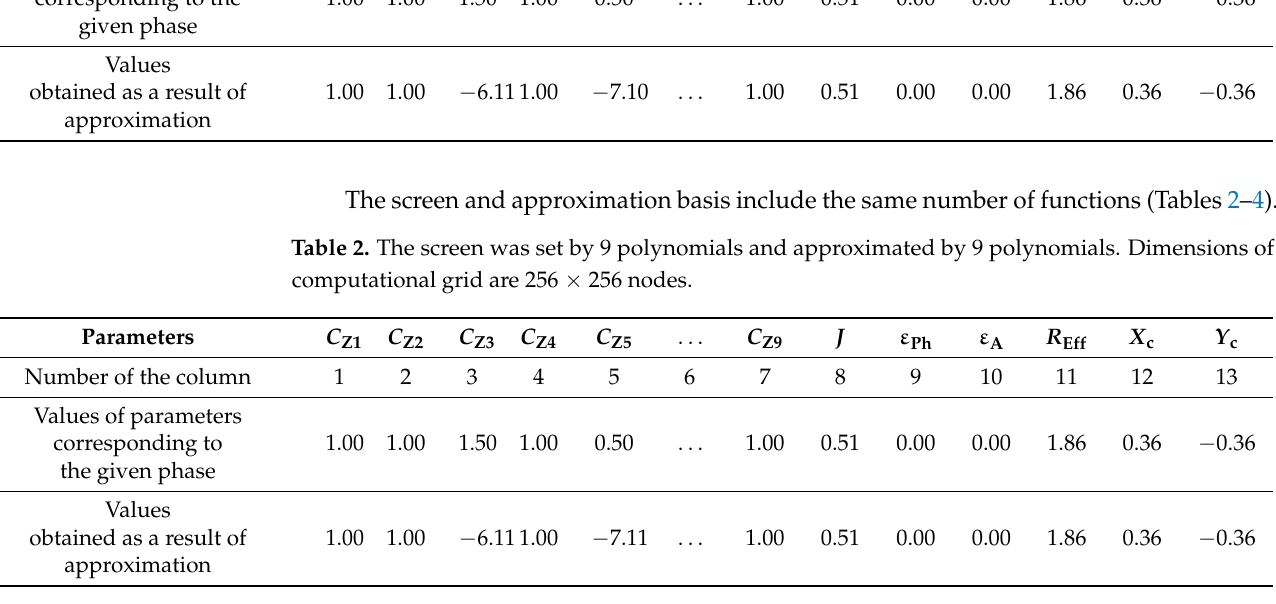
Figure 12. Dependence of dislocation number on distance Z passed by the beam. Calculation was performed for several realizations of random phase screens, numbers of which are printed near curves.